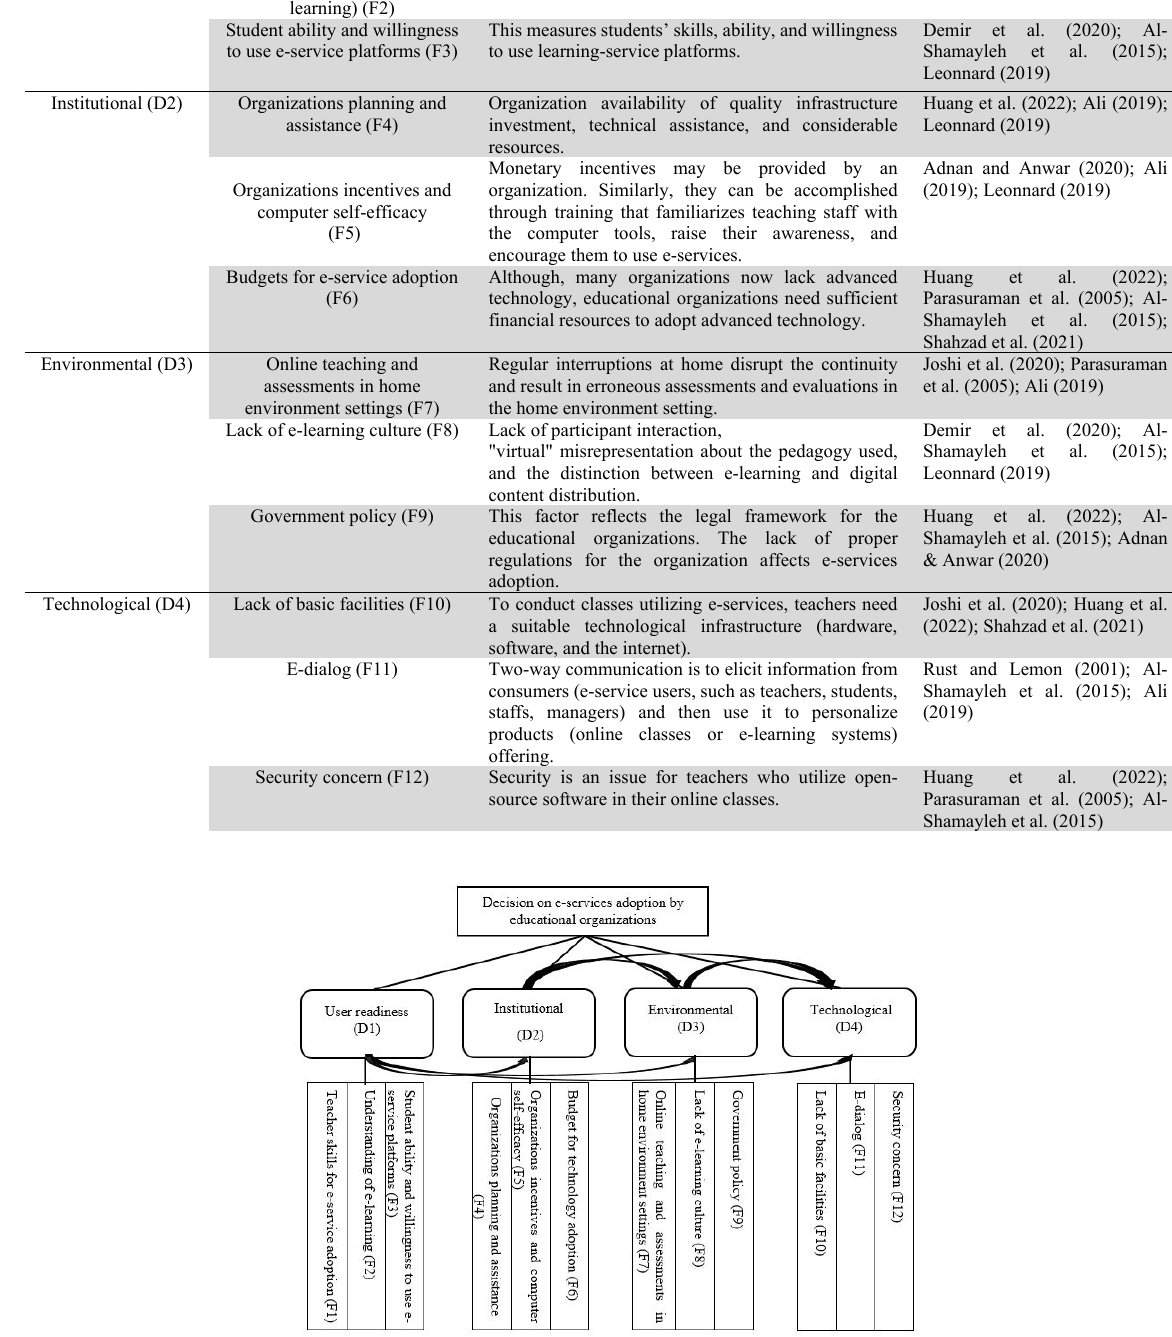
Fig. 1. Proposed model for e-services